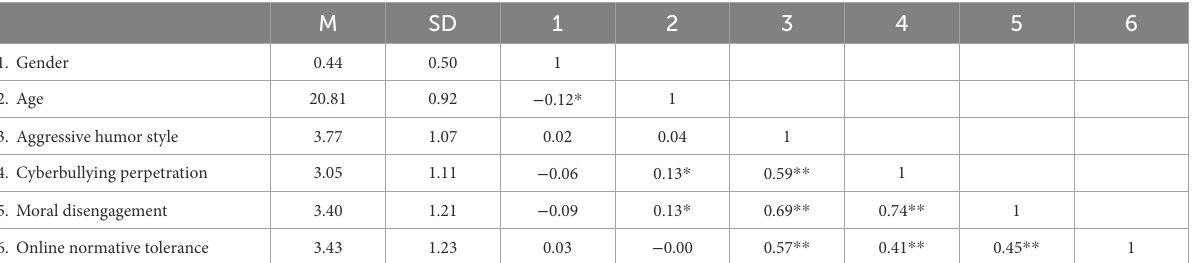
TABLE 1 Descriptive statistics and